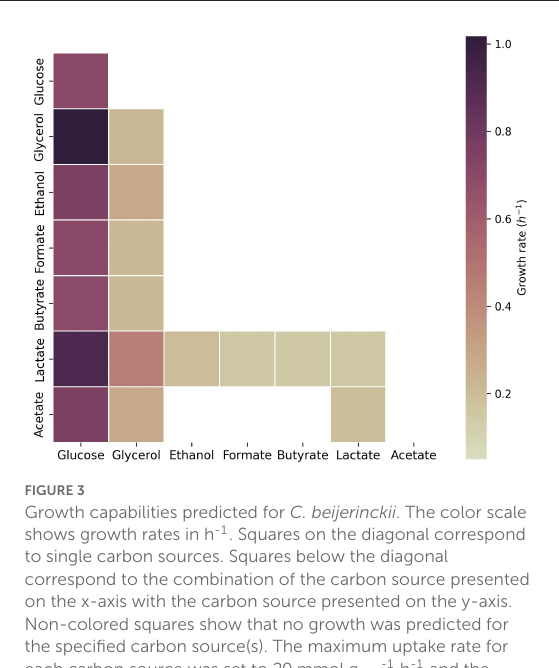
FIGURE3 Growth capabilities predicted for C. beijerinckii . The color scale shows growth rates in h -1 . Squares on the diagonal correspond to single carbon sources. Squares below the diagonal correspond to the combination of the carbon source presented on the x-axis with the carbon source presented on the y-axis. Non-colored squares show that no growth was predicted for the specified carbon source(s). The maximum uptake rate for each carbon source was set to 20 mmol g DW-1 h -1 and the minimum to 0.1 mmol g DW-1 h -1